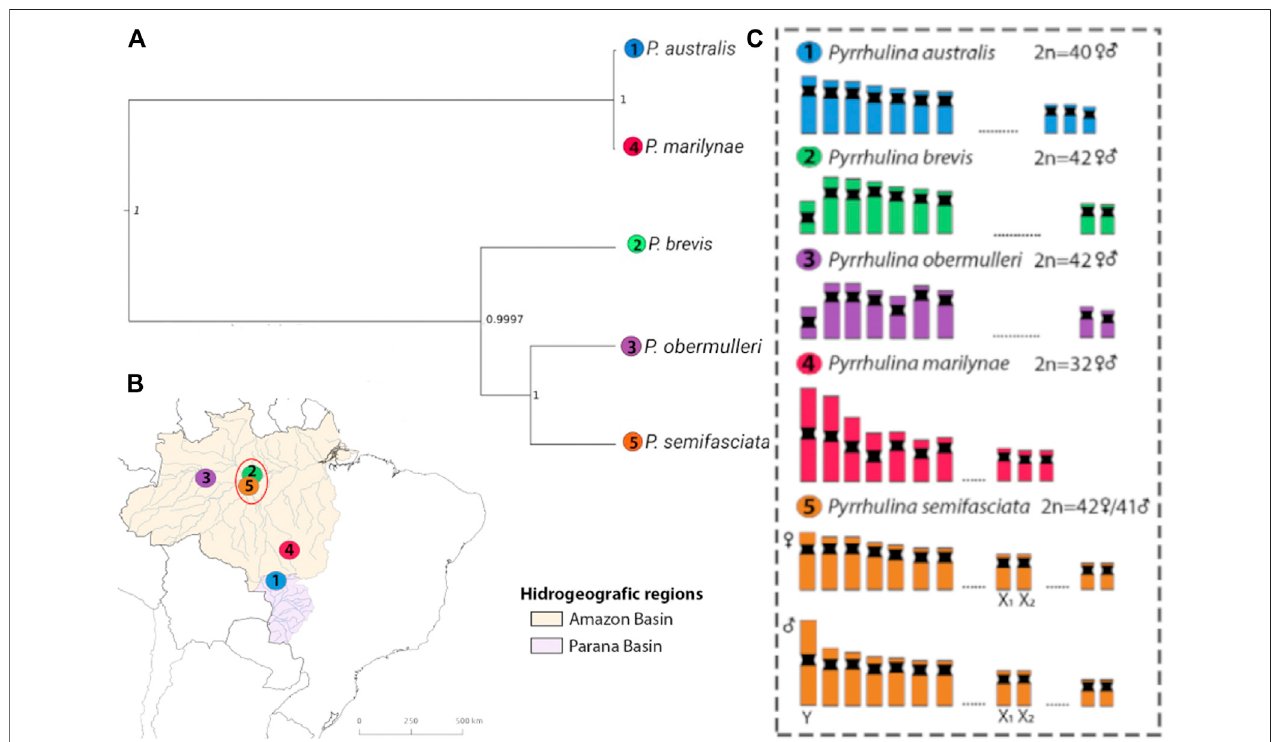
FIGURE 1 | Phylogenetic relationships of Pyrrhulina species analyzed and their distribution. (A) — Species tree recovered with SNAPP, with branch lengths measured in units of expected number of mutations per site, based on dataset I: P. australis (1), P. brevis (2), P. obermulleri (3); P. marilynae (4); and P. semifasciata (5). (B) — SouthAmericamapindicatingtheoriginof Pyrrhulina speciesanalyzed.Coloredareasindicatethedistributionofthespecies: P.australis (blue), P.brevis (green), P. obermulleri (yellow); P. marilynae (purple); and P. semifasciata (pink). The numbered circles indicate the collection sites of each species. The red ellipse indicates syntopic species (sampled in the same area). (C) — Idiograms with partial karyotypes of each species and the sex chromosomes exclusively found in P. semifasciata are boxed.